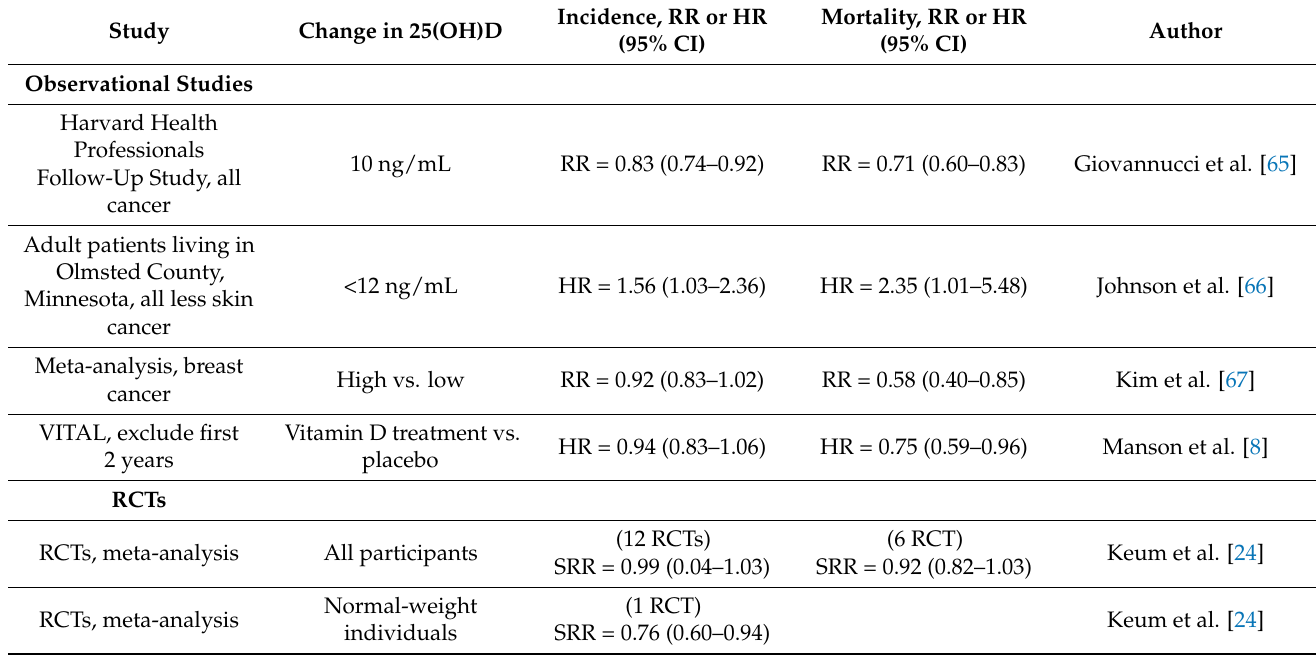
Table 1. Findings regarding cancer incidence and mortality rates with respect to 25(OH)D concentra- tions or vitamin D